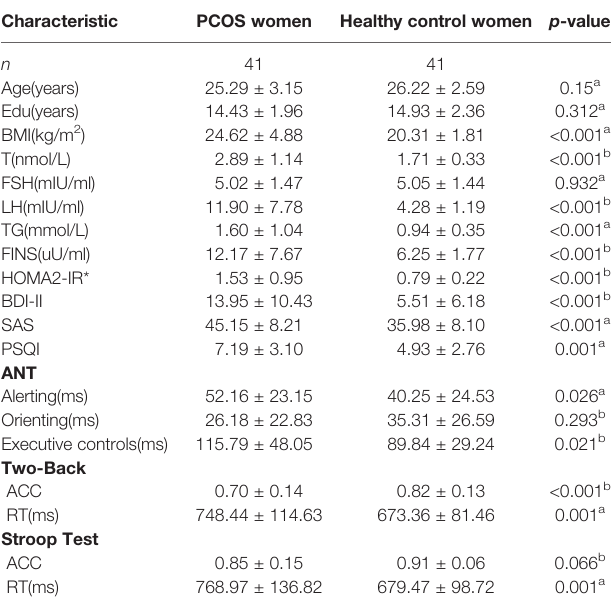
TABLE 1 | Demographic, clinical characteristics, mood, and cognitive performance